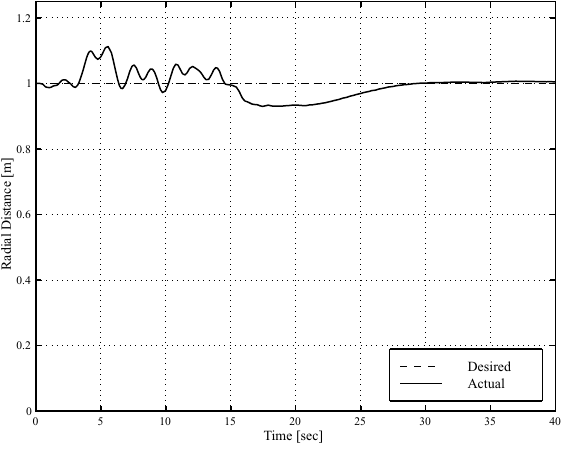
Fig. 27. Desired and actual radial distances for the damping case using the fuzzy controller.